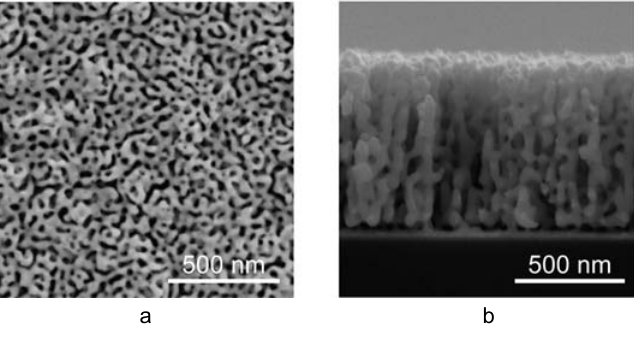
Figure 1. Scanning electron micrographs of typical np-Au morphology: (a) top view, and (b) cross-sectional view.